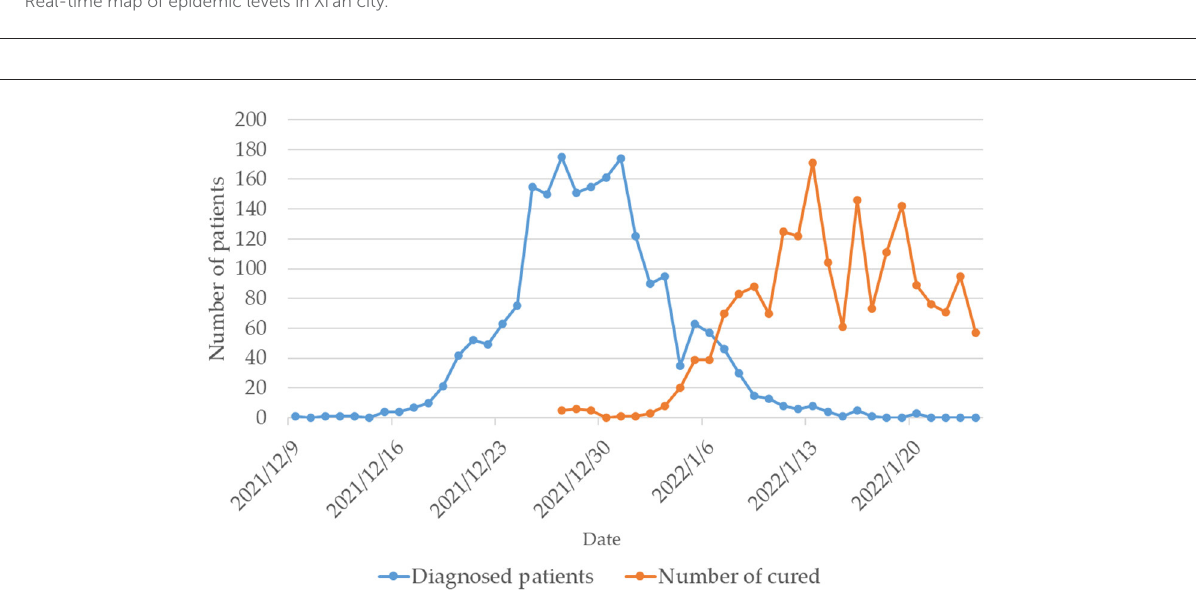
FIGURE1 Real-time map of epidemic levels in Xi’an city.